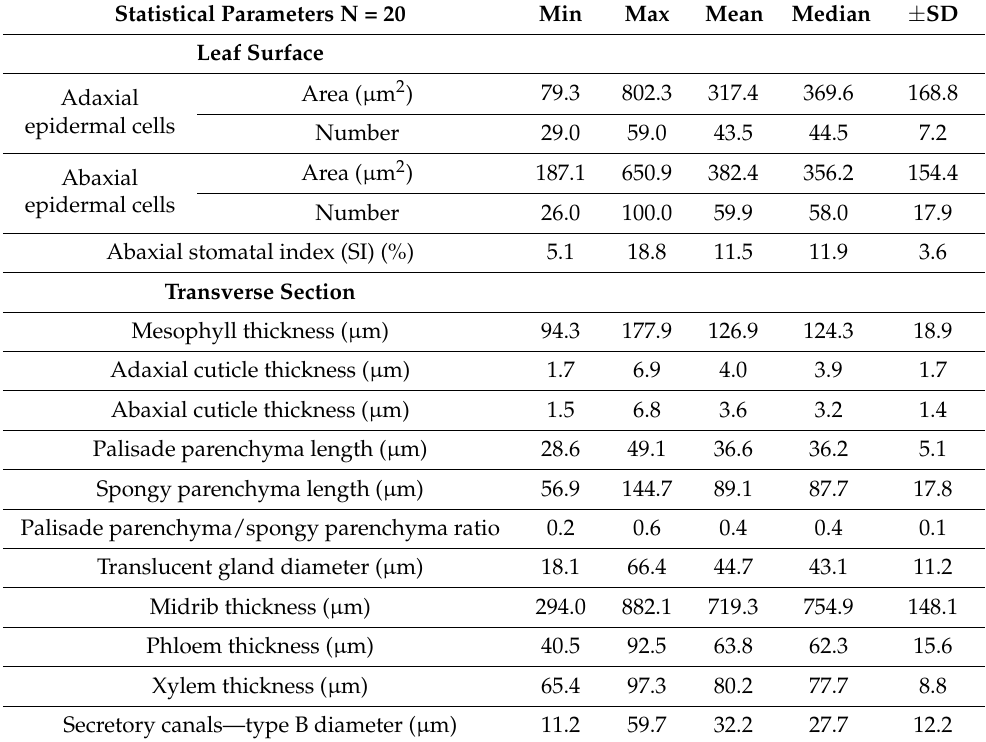
Table 3. H. foliosum leaf: LM microscopic